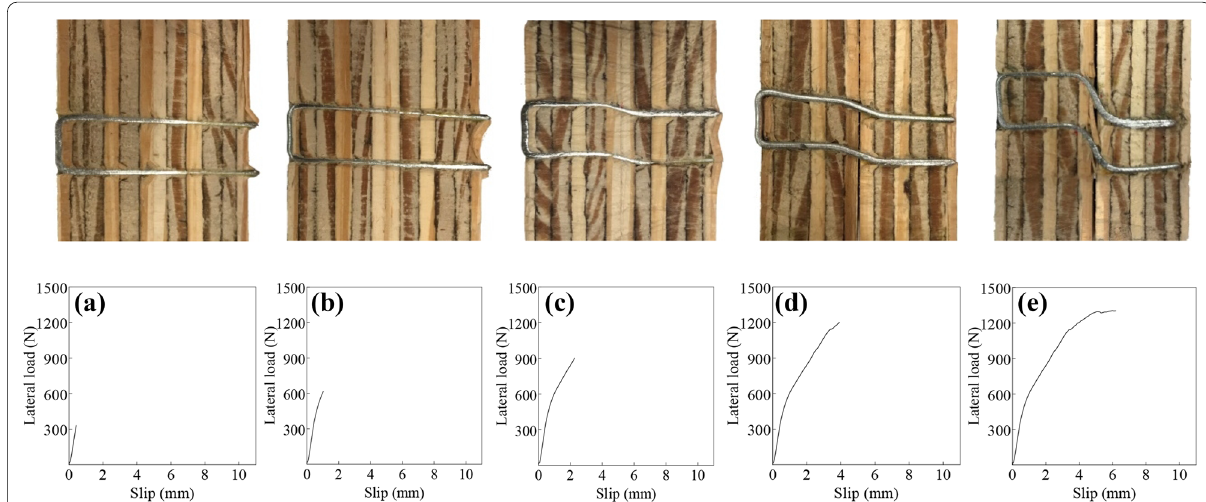
Fig. 11 Images showing single staple connection failure modes in terms of the shapes of deformed staple legs and plywood material crushed underneath staple legs taken at different loading levels: a 325.9 N below the mean value of the first proportional limit point, F pl mean value of the first yield point, F y ; c 900.0 N below the mean value of the second proportional limit point, F pl − 1 value of the second yield point, F y